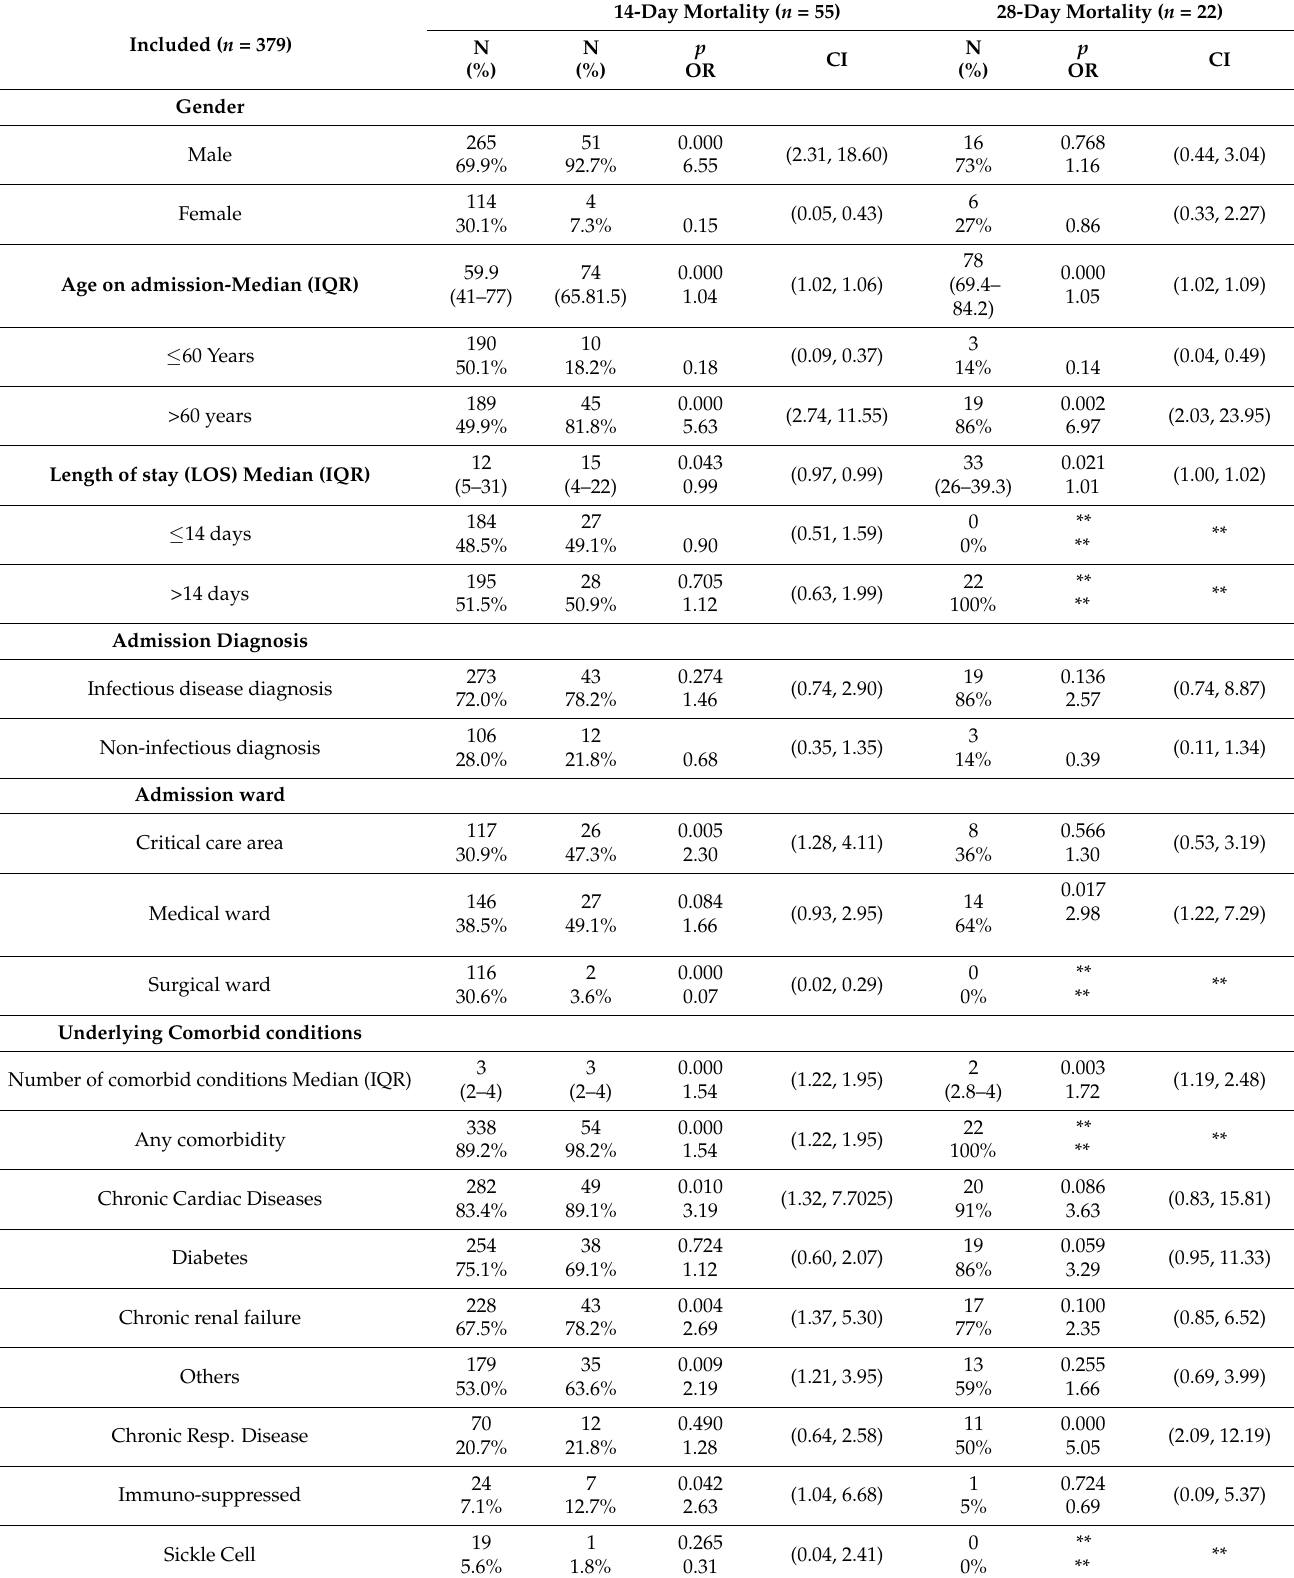
Table A2. Risk factors for 14 and 28-day mortalities (Binary logistic